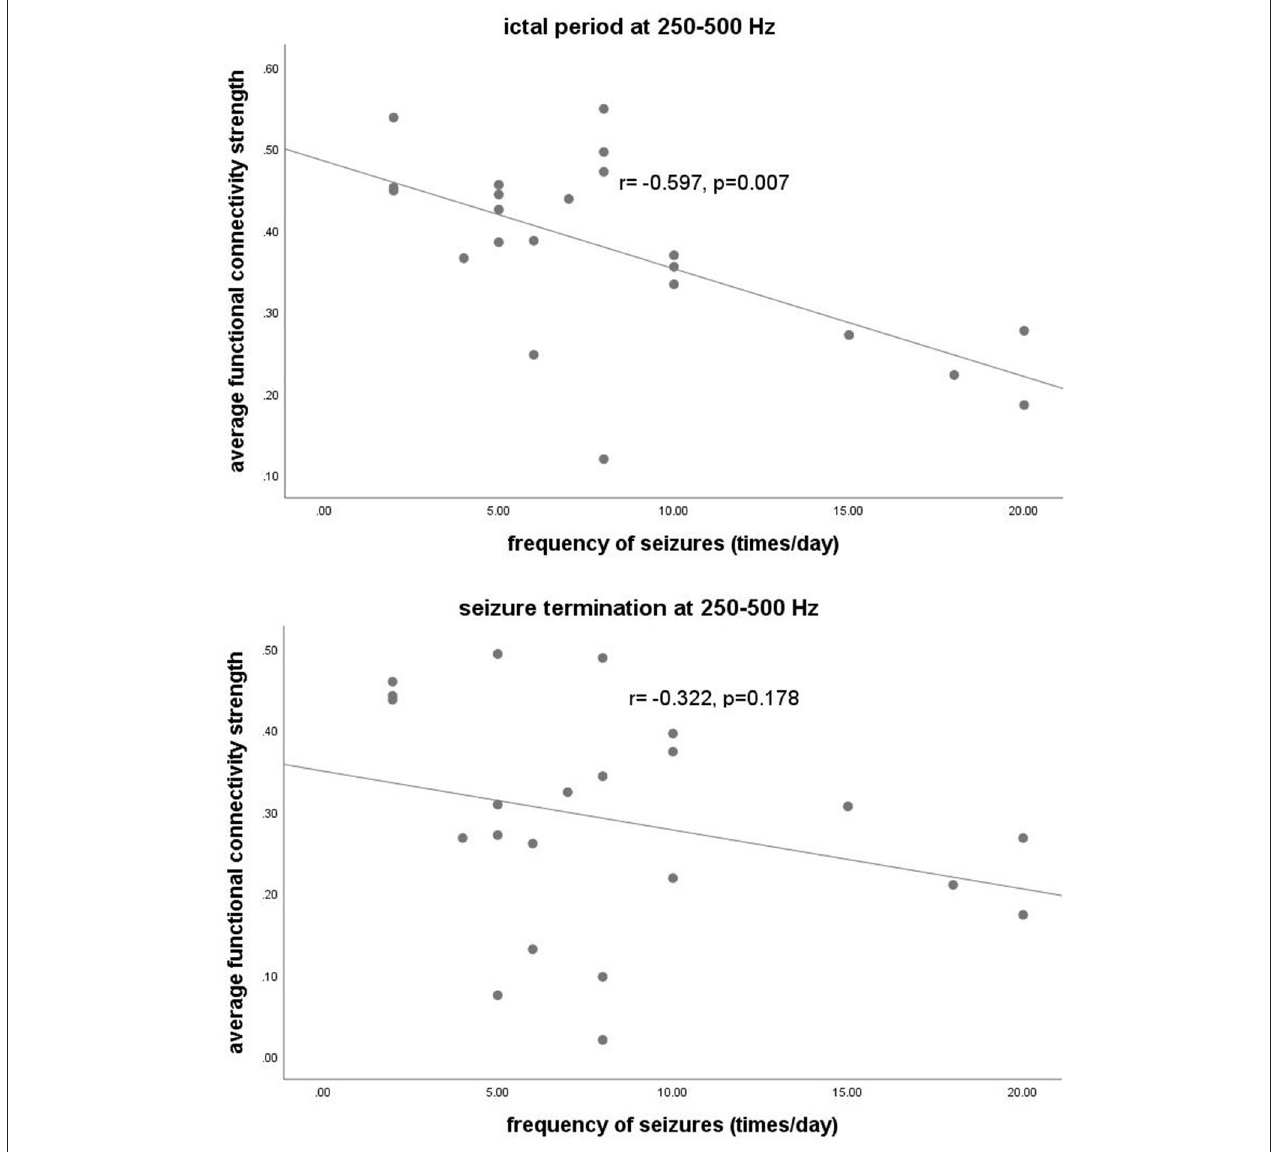
FIGURE 5 | The y -axis represents the functional connectivity strength. The x -axis represents seizure frequency. Partial correlation analysis showed that the functional connectivity strength at 250–500Hz during the ictal period was negatively correlated with the frequency of seizures ( r = − 0.597, p = 0.007) after adjustment for sex, age, and duration of